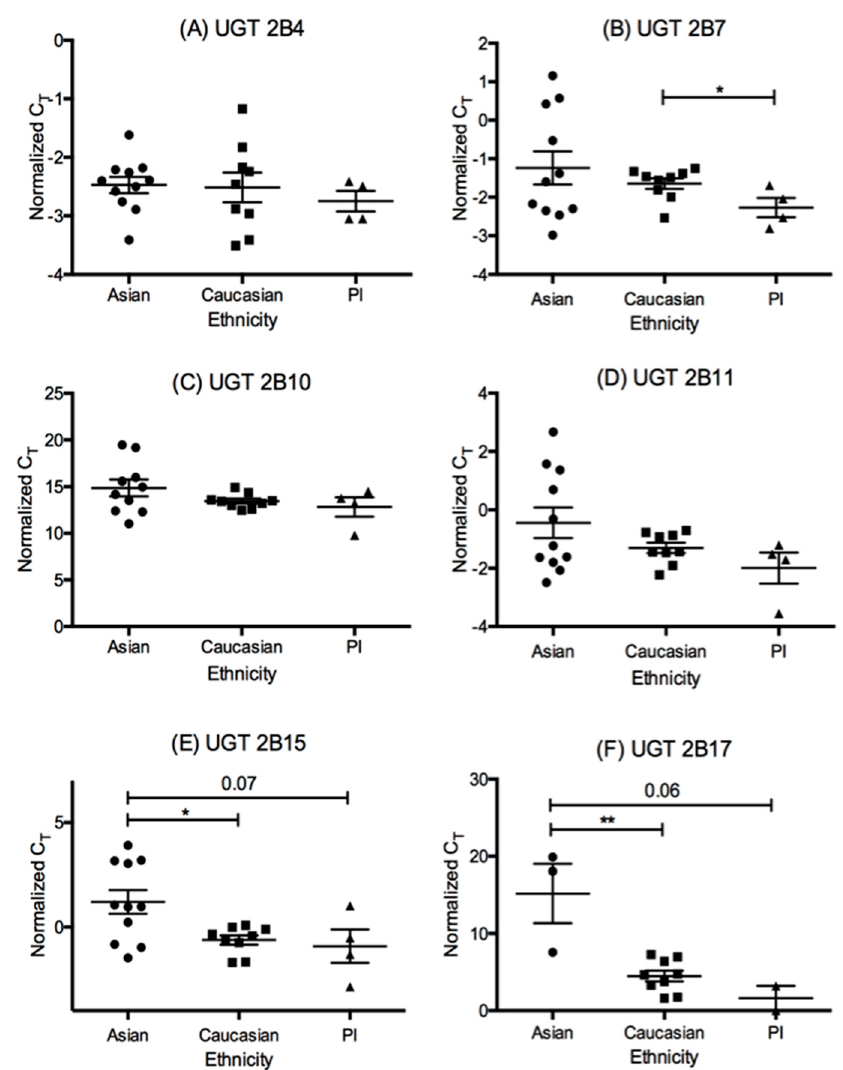
Figure 4. The quantitative PCR Δ C T values in Asian (A, n = 11), Caucasian (C, n = 9), and Pacific Islander (PI, n = 4) ethnicities for all examined UGT2B isoforms in liver. Statistical significance is listed for p -values ≤ 0.05 (*), ≤ 0.01 (**), and p values approaching significance (<0.1). Note that a higher Δ C T means a lower level of mRNA. ( A – F ) represent results for each individual UGT2B subfamily isoform.